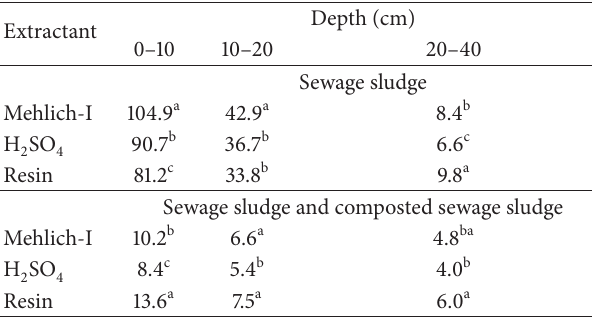
Table 2: Mean extracted phosphorus by Mehlich-I, H resin in the two experiments described in the text: one with amendment of sewage sludge and the other with the amendment of sewage sludge and composted sewage sludge ( 𝑛 = 4 ).